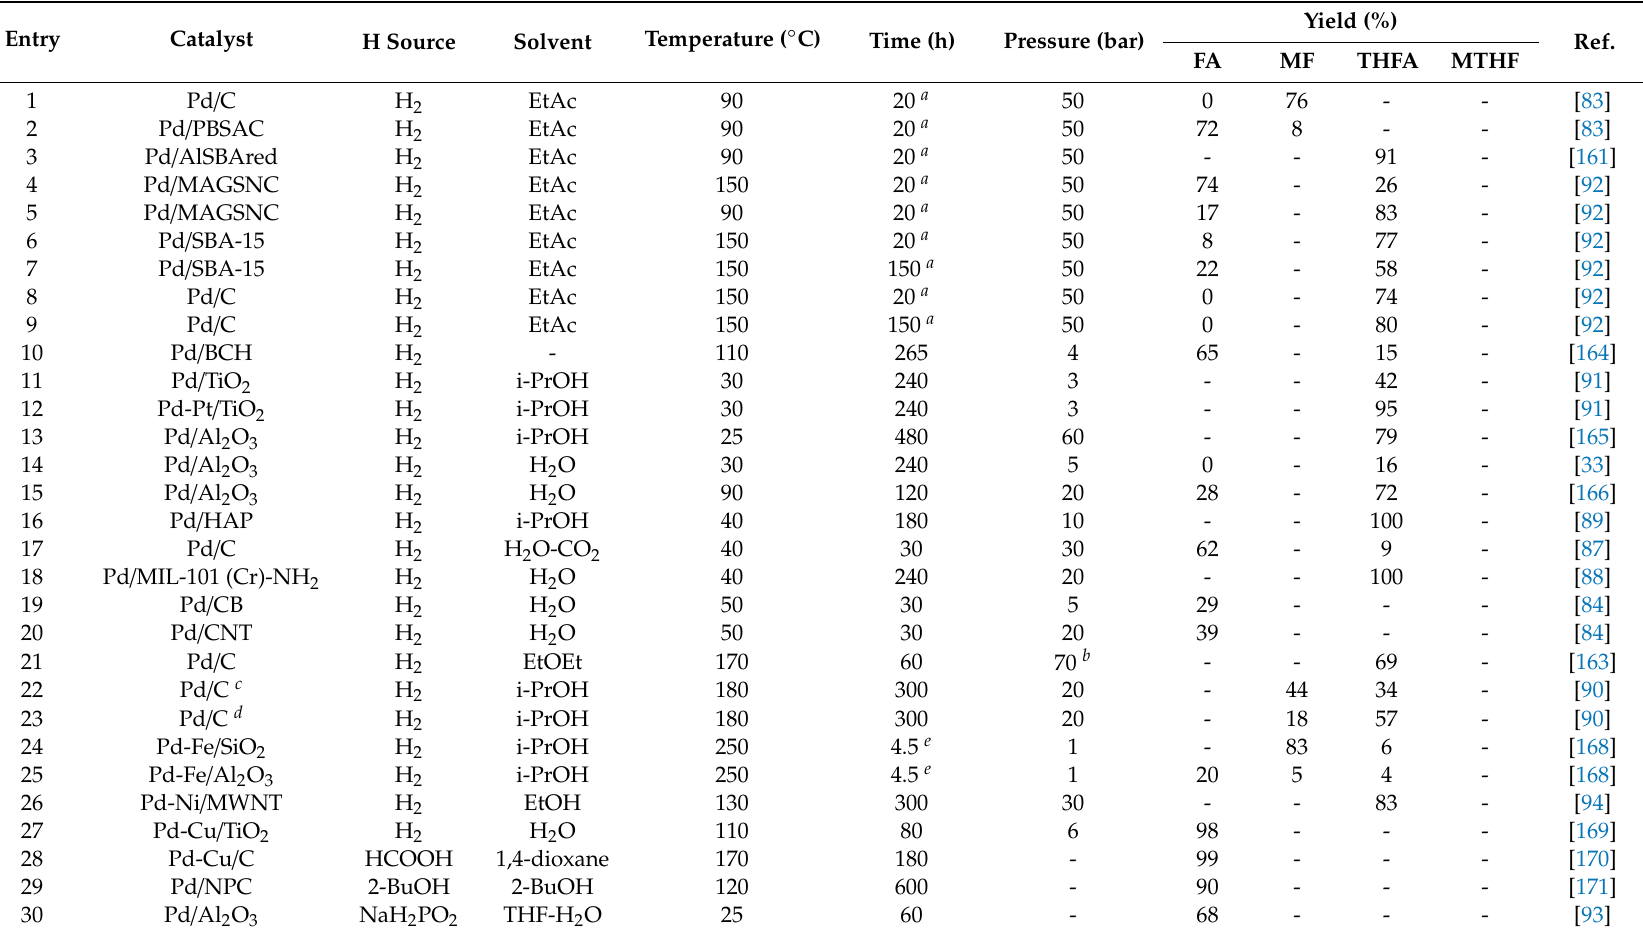
Table 4. Furfural hydrogenation over Pd-based